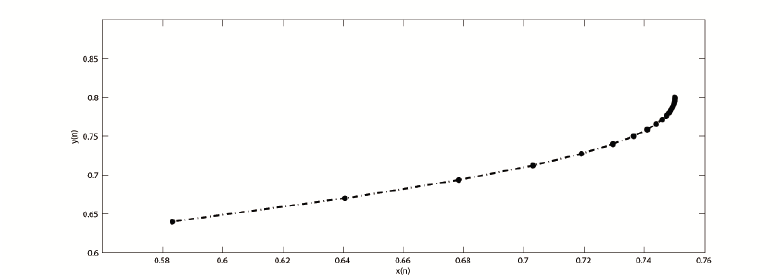
Figure 2. The stability of equilibrium of (1.4) while α i ≤ β i